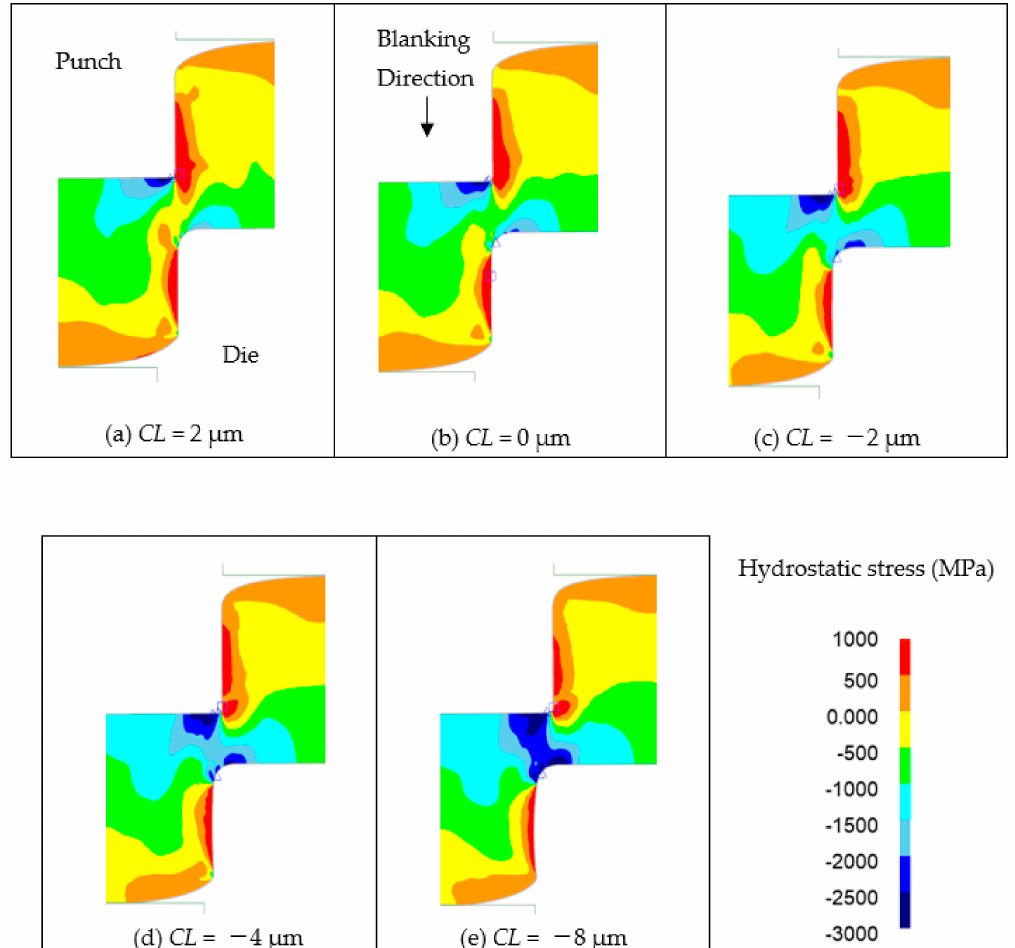
Figure 8. Comparison of hydrostatic stress for 70%t punch penetration of various clearance